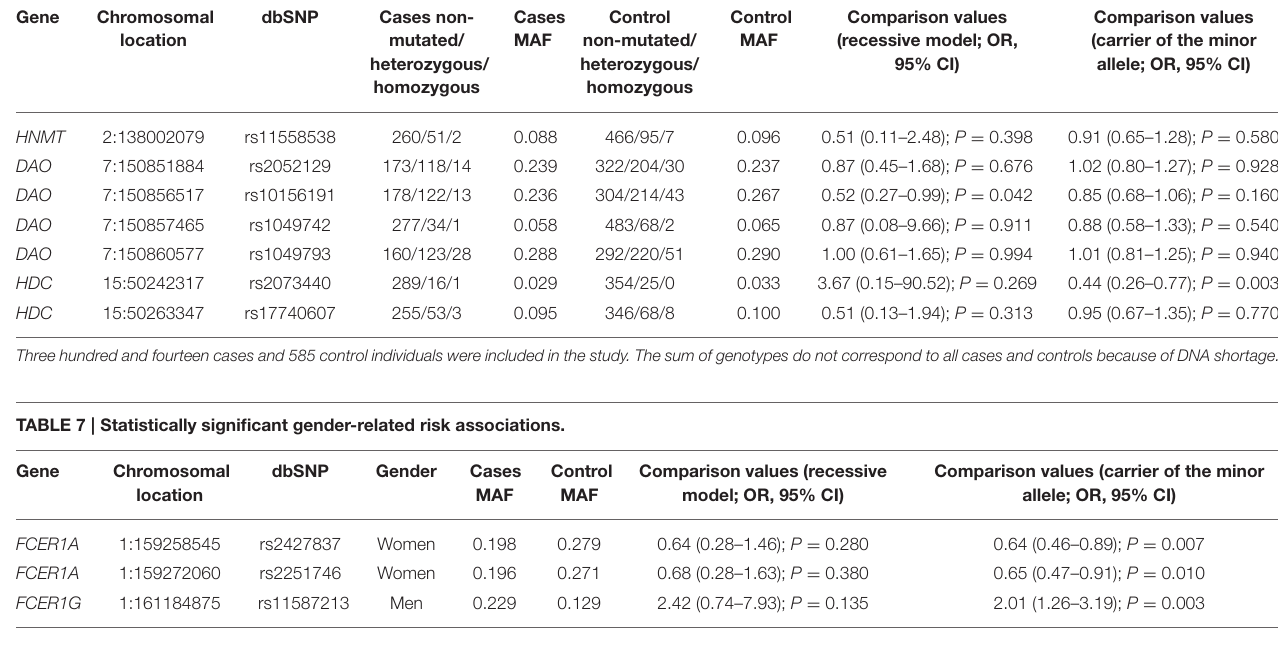
TABLE 6 | SNPs related with histamine synthesis and degradation analyzed in this study. Gene Chromosomal dbSNP Cases non- Cases Control Control Comparison values location mutated/ MAF non-mutated/ MAF (recessive model; OR, heterozygous/ heterozygous/ 95% CI) homozygous homozygous